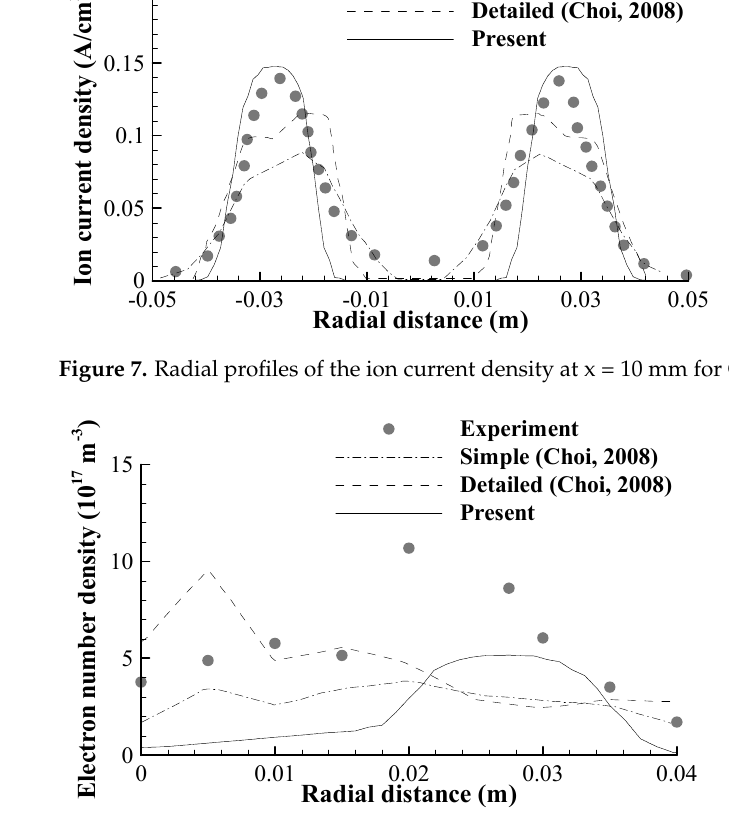
Figure 8. Radial profiles of the electron number density at x = 10 mm for Case 1.